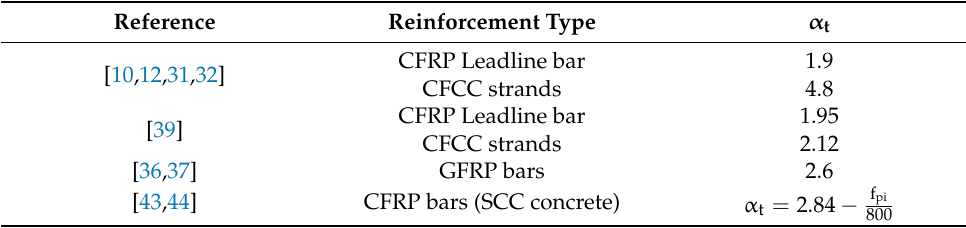
Table 9. Summary of material dependent coefficient α t .